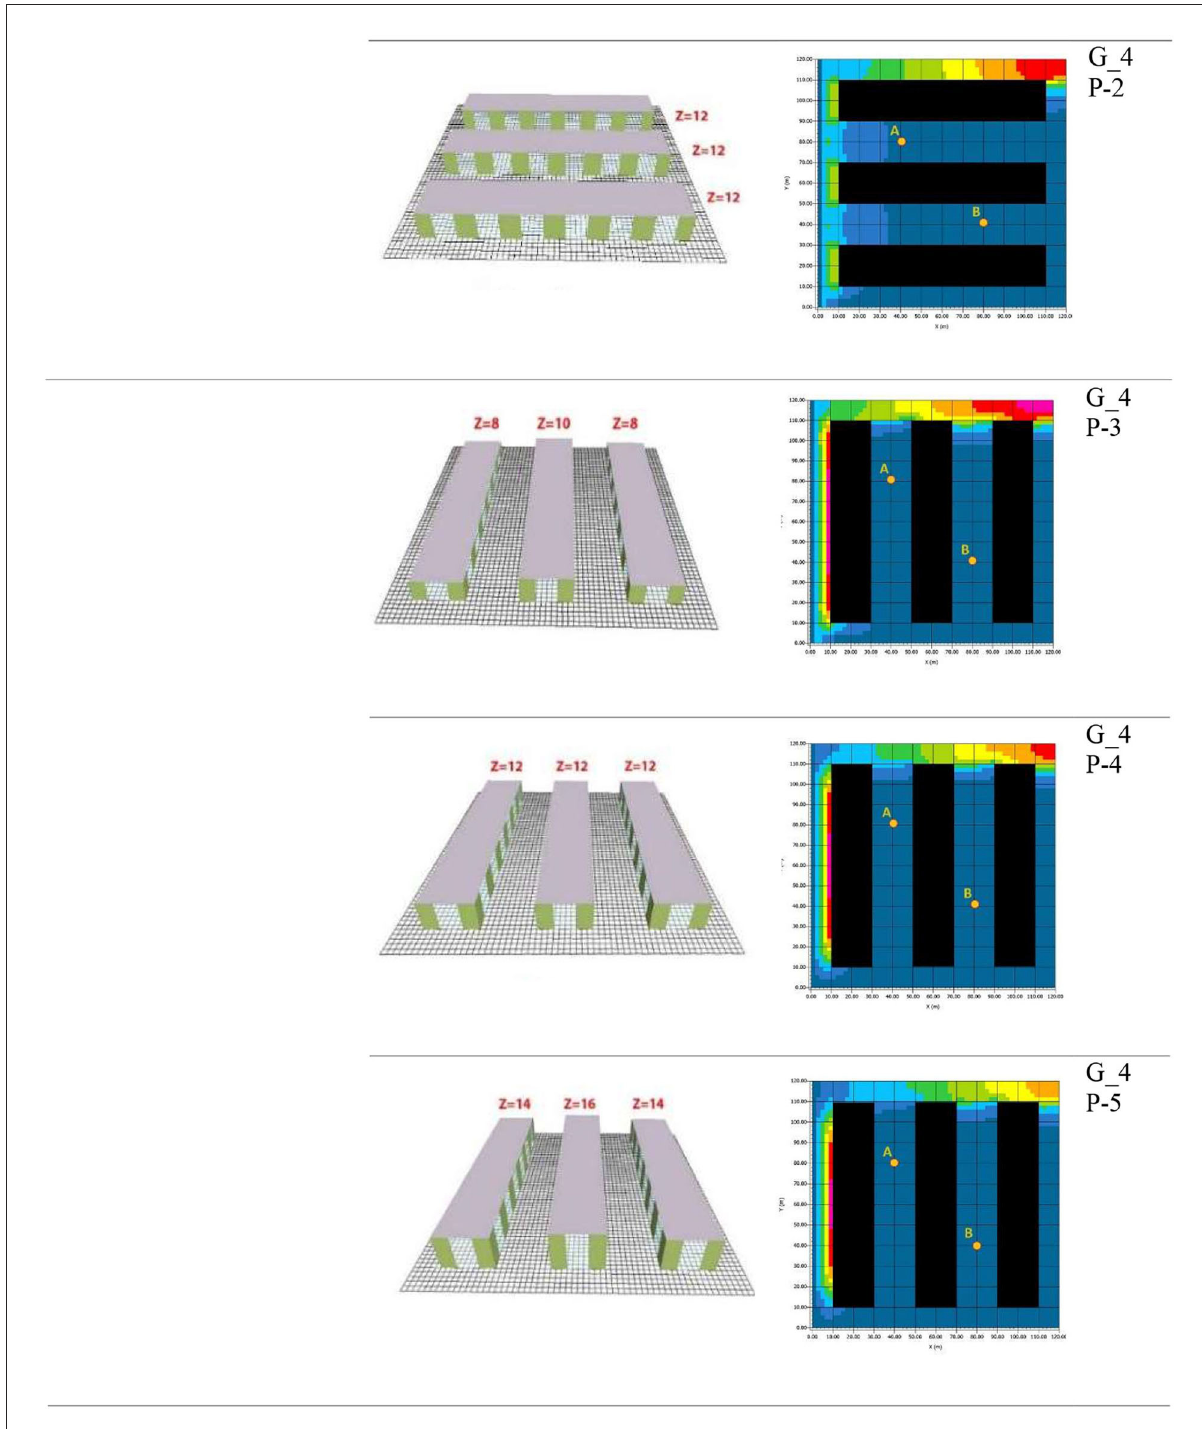
FIGURE3 Selected sample point to